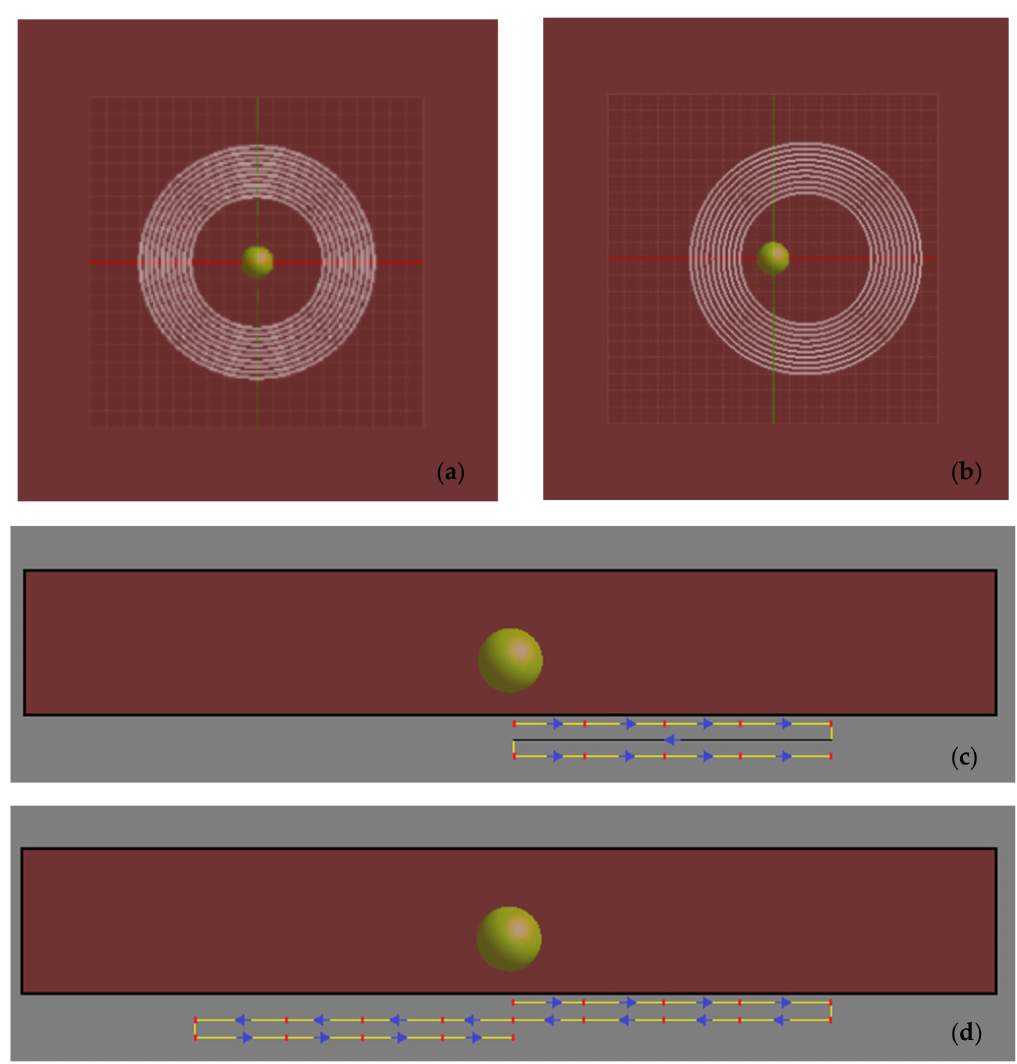
Figure 2. ( a ) Initial position of the coil. ( b ) Final position of the coil during its linear motion along x- axis (center of coil at 20 mm away from its initial position). ( c ) Cross-sectional image of the simulated scheme for the unidirectional case with the coil trajectory depicted below the phantom. The initial position of the coil center coincided with the phantom center and is defined as x = 0. The blue arrows depict the direction of coil motion. Each red point corresponds to the position where the coil temporarily remains while the moving step is depicted with a yellow line and equals 5 mm (distance from point to point). The black line shows the return of the coil to the initial position with a field downtime of 2 s. ( d ) Cross-sectional image of the simulated scheme for the bidirectional case. After the coil reaches its maximum displacement at x = 20 mm, it turns to the opposite direction until it reaches the position x = − 20 mm, with respect to the phantom center, without the field